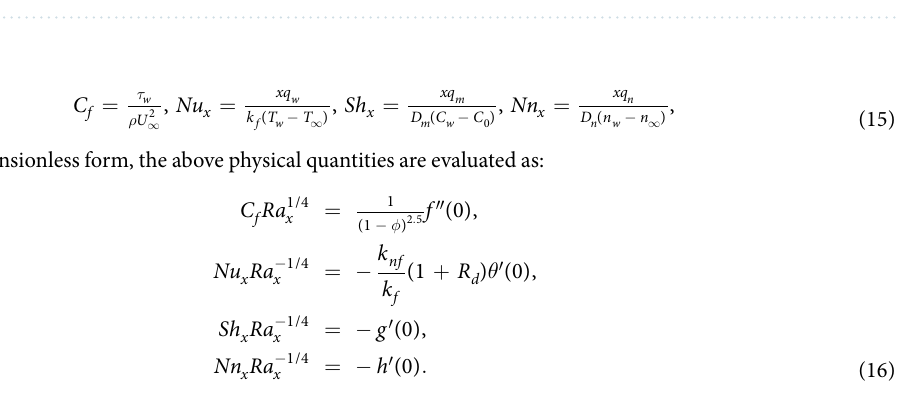
Table 2. Comparison with Khan et al . 56 in limiting case for the values of φ versus f (0) ″ and (0) θ − ′